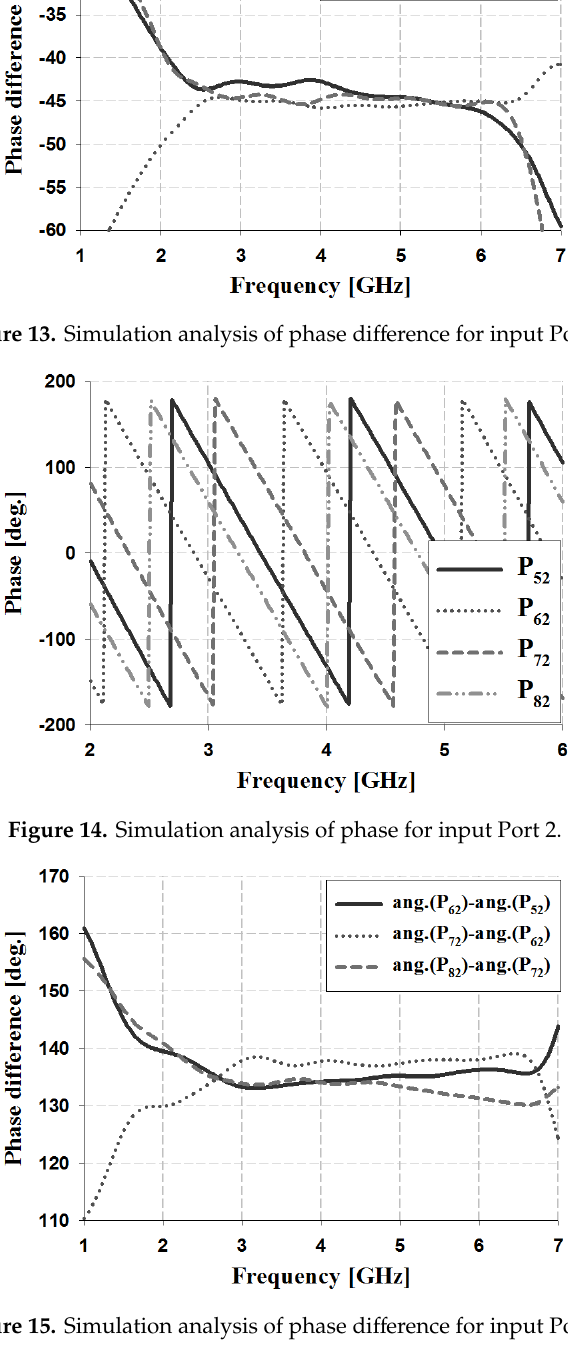
Figure 15. Simulation analysis of phase difference for input Port 2. Table 2. Simulation results of phase difference for 4 × 4 Butler matrix.